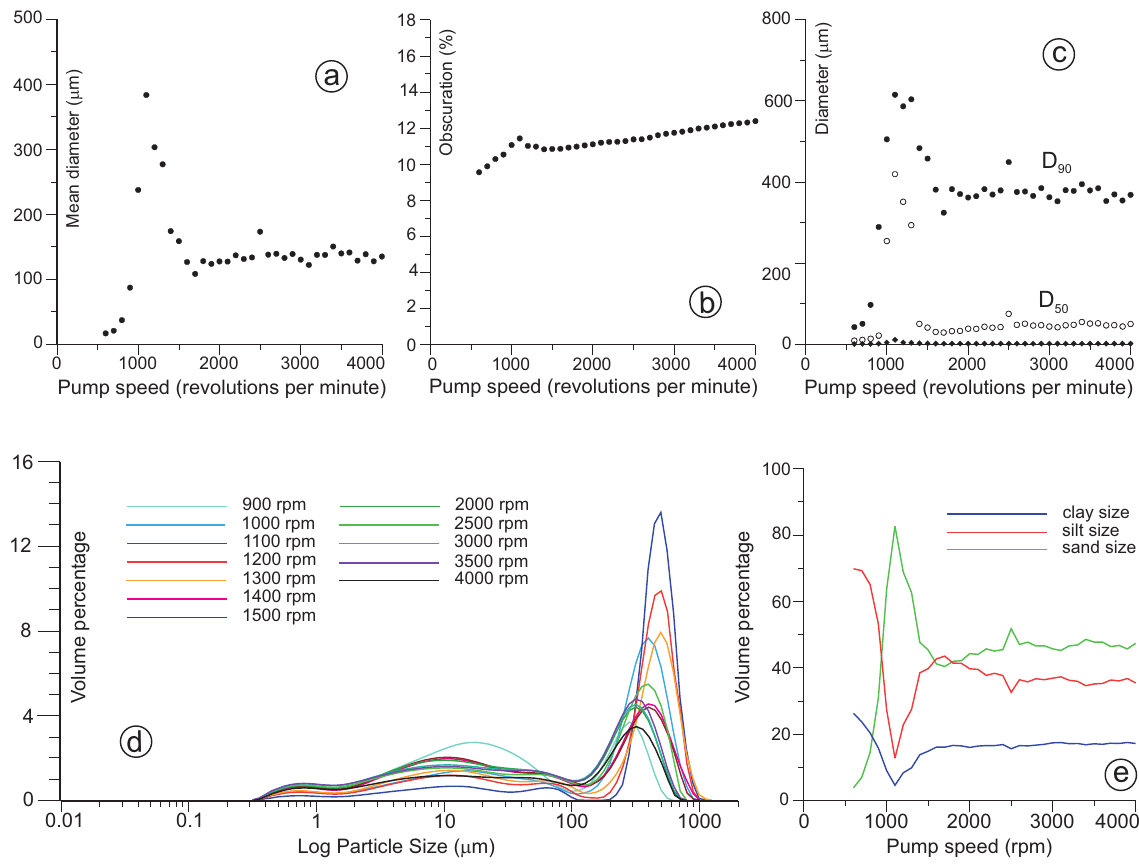
Fig. 5. Results of the pump speed test P 1 performed on sub-sample aliquot CABRE3b by the Hydro 2000 MU dispersion unit. (a) Mean diameter value evolution with increasing the pump speed from 600 up to 4000rpm. (b) Laser obscuration value progression during the same test. (c) Progression of D 10 , D 50 , and D 90 percentiles during the same test. (d) Granulometric curves obtained by averaging data from the corresponding 10 measurement runs during representative pump speed steps. (e) Distribution of clay, silt, and sand size fractions during the